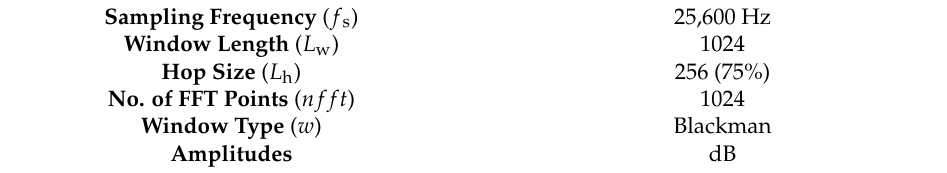
Table 2. STFT parameters.